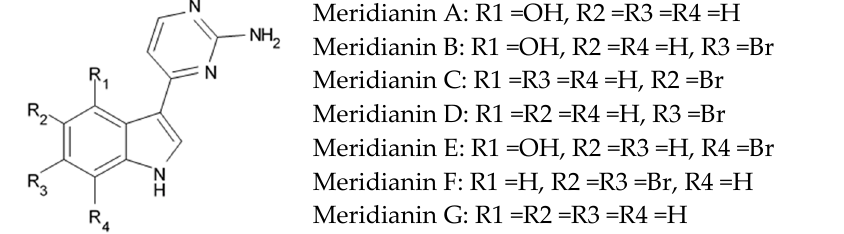
Figure 1. Chemical structure of meridianins A–G [44].